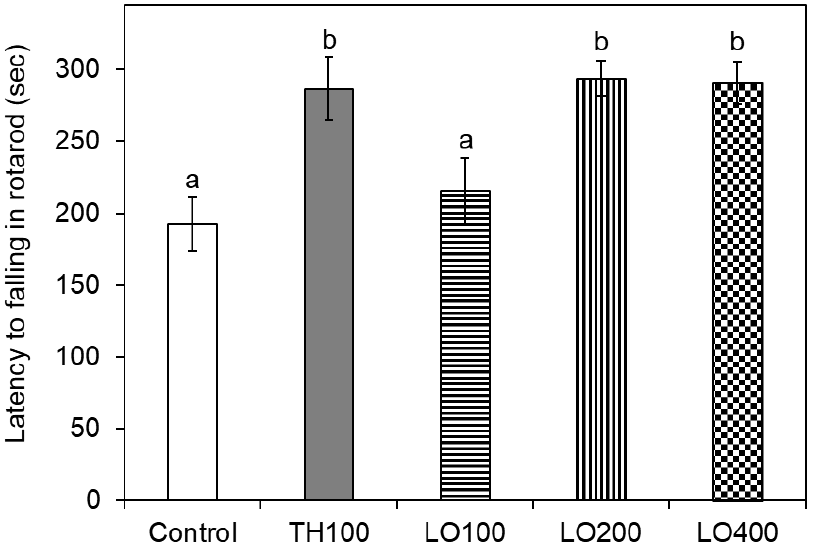
Figure 4. Effect of different doses of C. osmophloeum ct. linalool leaf oil on motor coordination in ICR mice by the rotarod assay. Data are presented as mean ± S.D. ( n = 7); TH100: trazodone hydrochloride, 100 mg/Kg; LO100, LO200, and LO400: leaf oil, 100 mg/Kg, 200 mg/Kg, and 400 mg/Kg. Different letters (a–b) in the figure are significantly different at the level of p < 0.05 according to the Scheffe’s test.